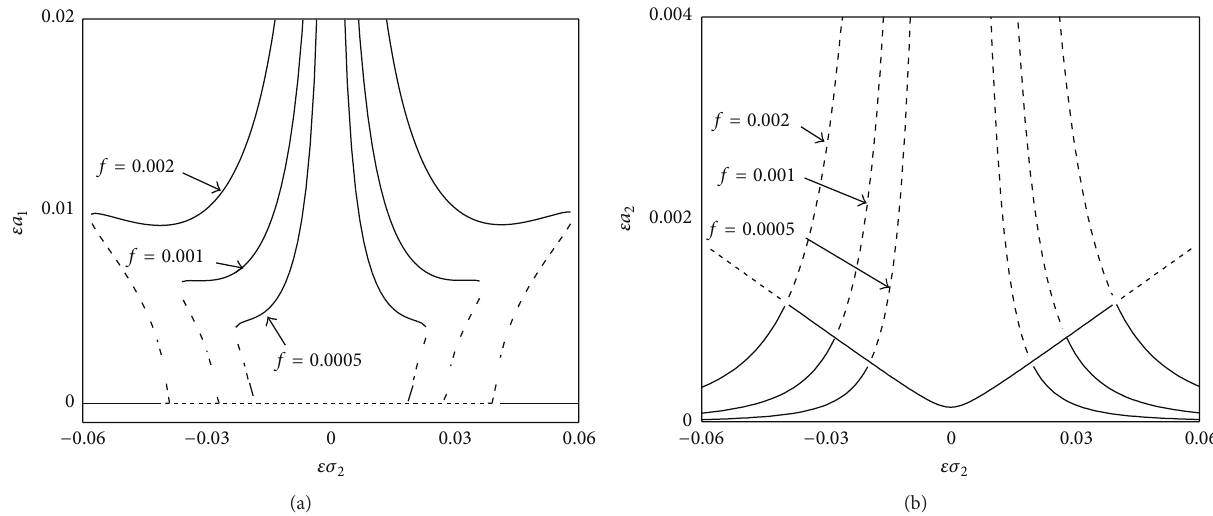
Figure 7: Amplitude-frequency curves of the second superharmonic resonance for different external excitation amplitudes: (a) the first mode and (b) the second